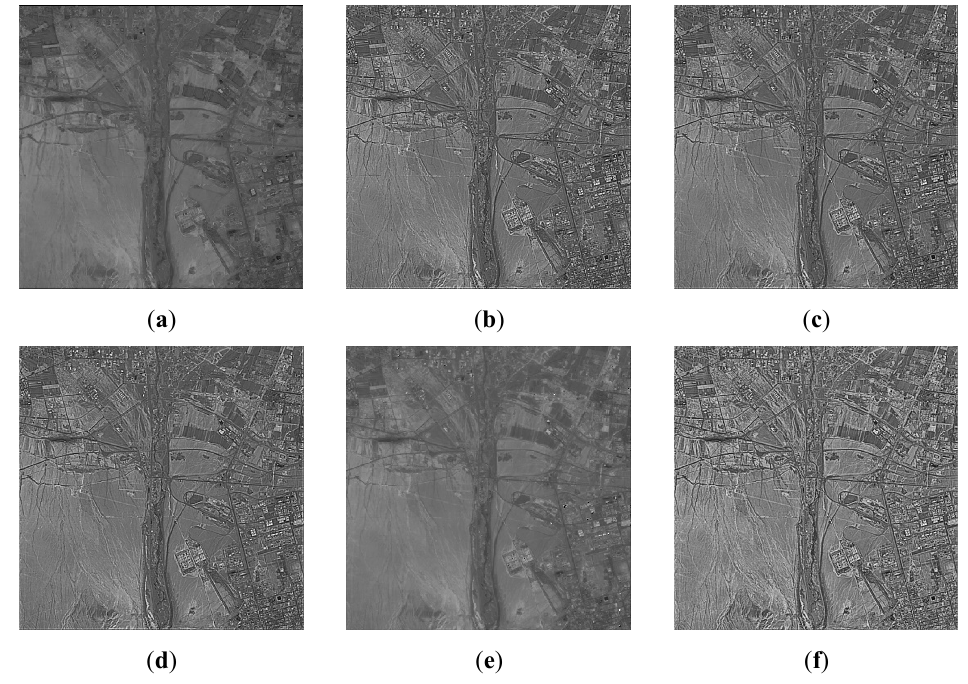
Figure 8. Enhanced image of data 2 by using our IDCP algorithm with: ( a ) Sobel; ( b ) Laplacian; ( c )